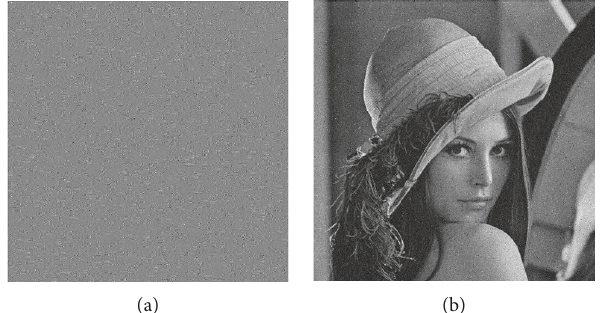
Figure 9: Effect of noise attacks with β � 10. (a) Encrypted image with noises. (b) Decrypted image.